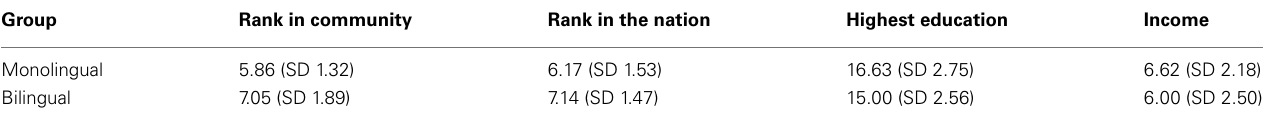
Table 1 | Mean scores for the key socioeconomic status (SES) measures used from the MacArthur Network on SES and health.